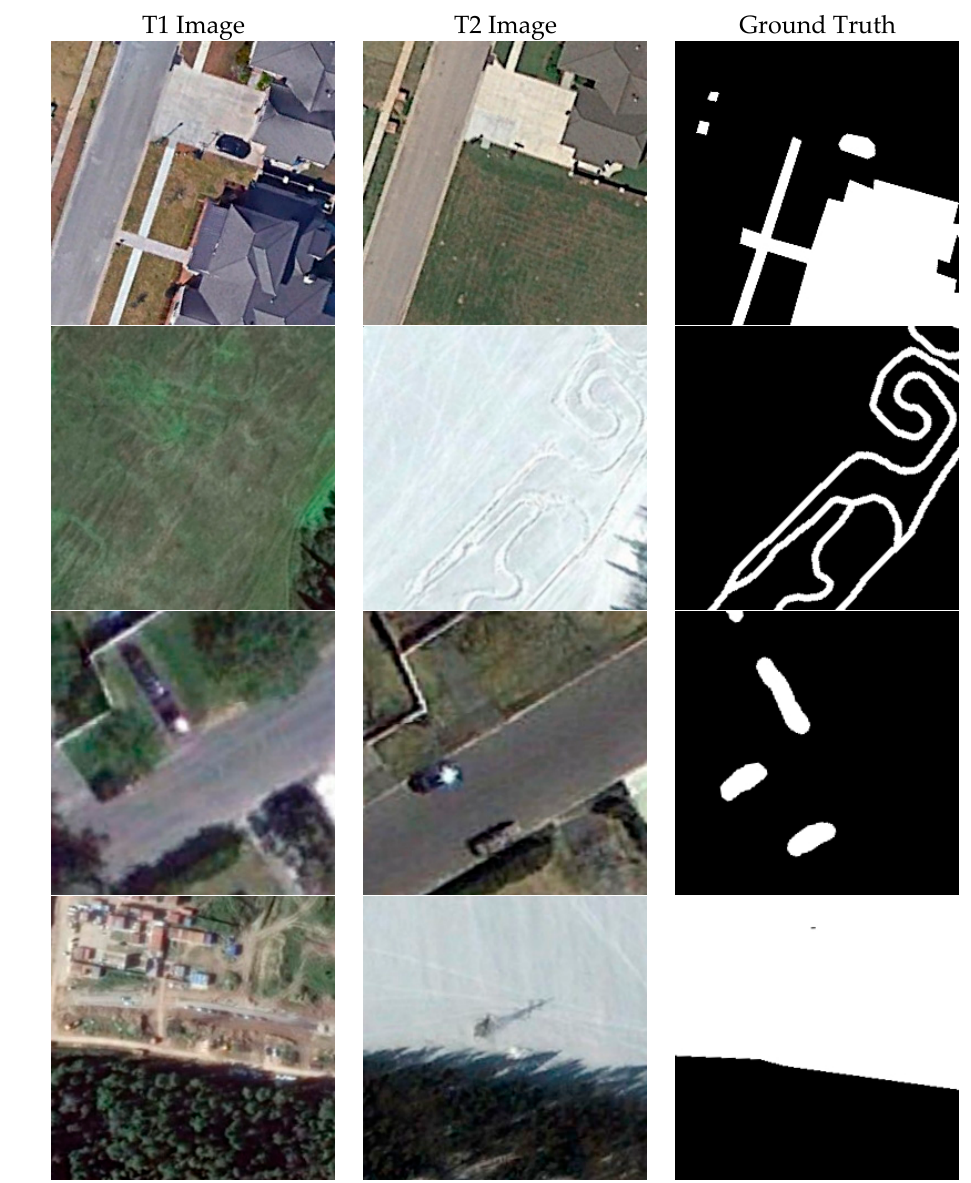
Figure 4. CDD dataset with different object changes.